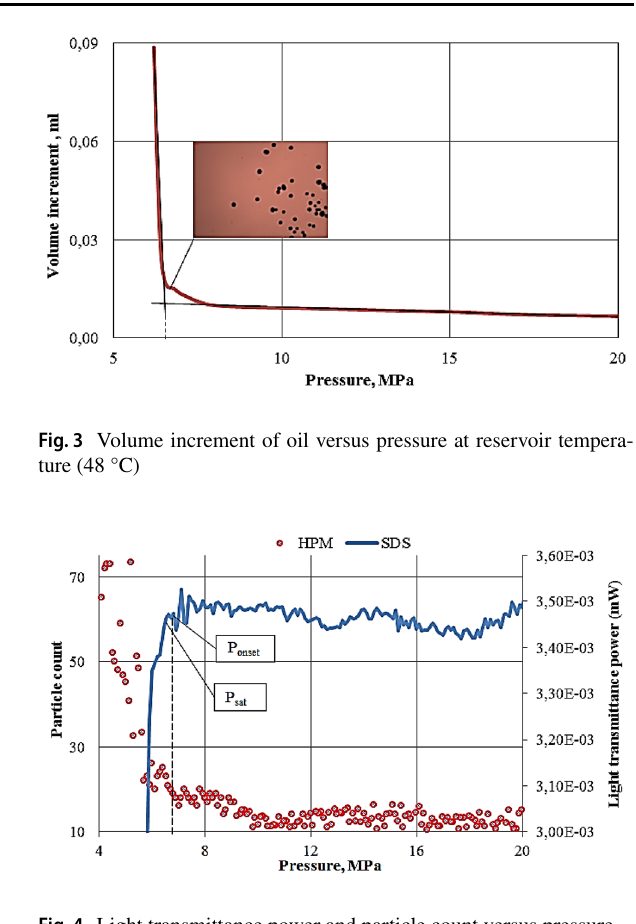
Fig. 4 Light transmittance power and particle count versus